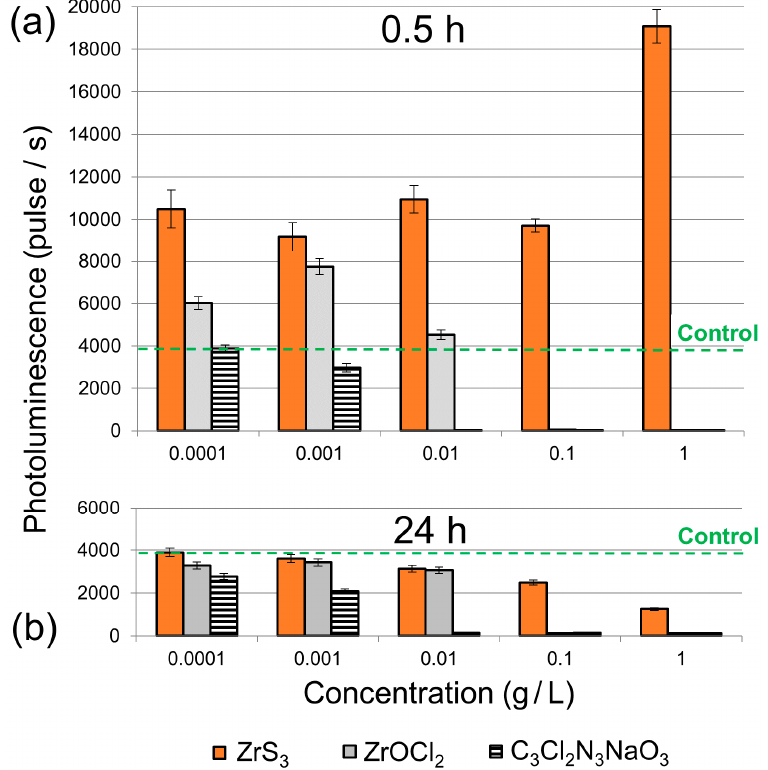
Figure 2. E. coli luminescence values in ( a ) as-prepared (0.5 h) and ( b ) 24 h solutions of ZrS 3 , ZrOCl 2 and C 3 Cl 2 N 3 NaO 3 . For ZrOCl 2 solutions, the concentrations were 0.000172, 0.00172, 0.0172, 0.172 and 1.72 g / L, so that they matched the 0.0001, 0.001, 0.01, 0.1 and 1 g / L ZrS 3 suspensions in the zirconium concentrations, respectively.